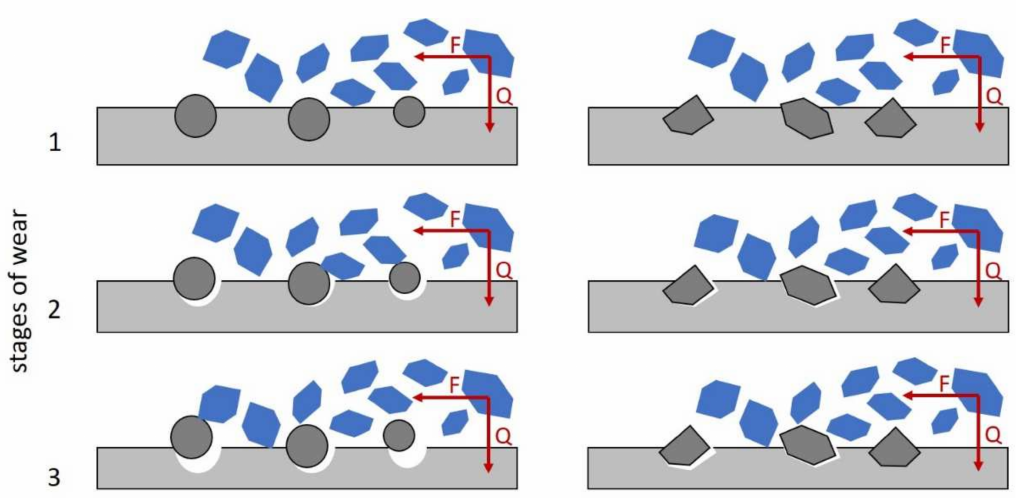
Figure 2. Three consecutive stages of abrasive wear for material with fine spherical carbides and material with fine irregularly shaped carbides.